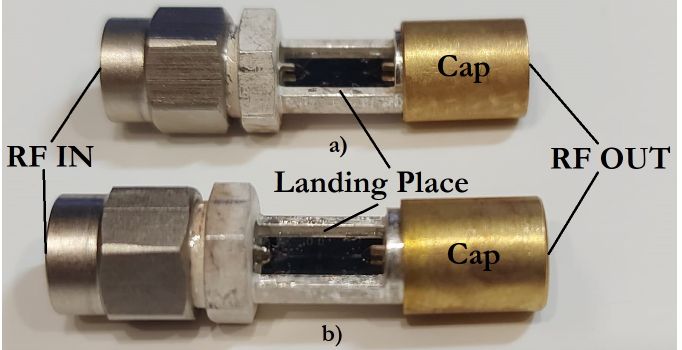
Figure 25. The manufactured experimental samples of RF MEMS switches: ( a ) RF MEMS switch (A); ( b ) RF MEMS switch (B).